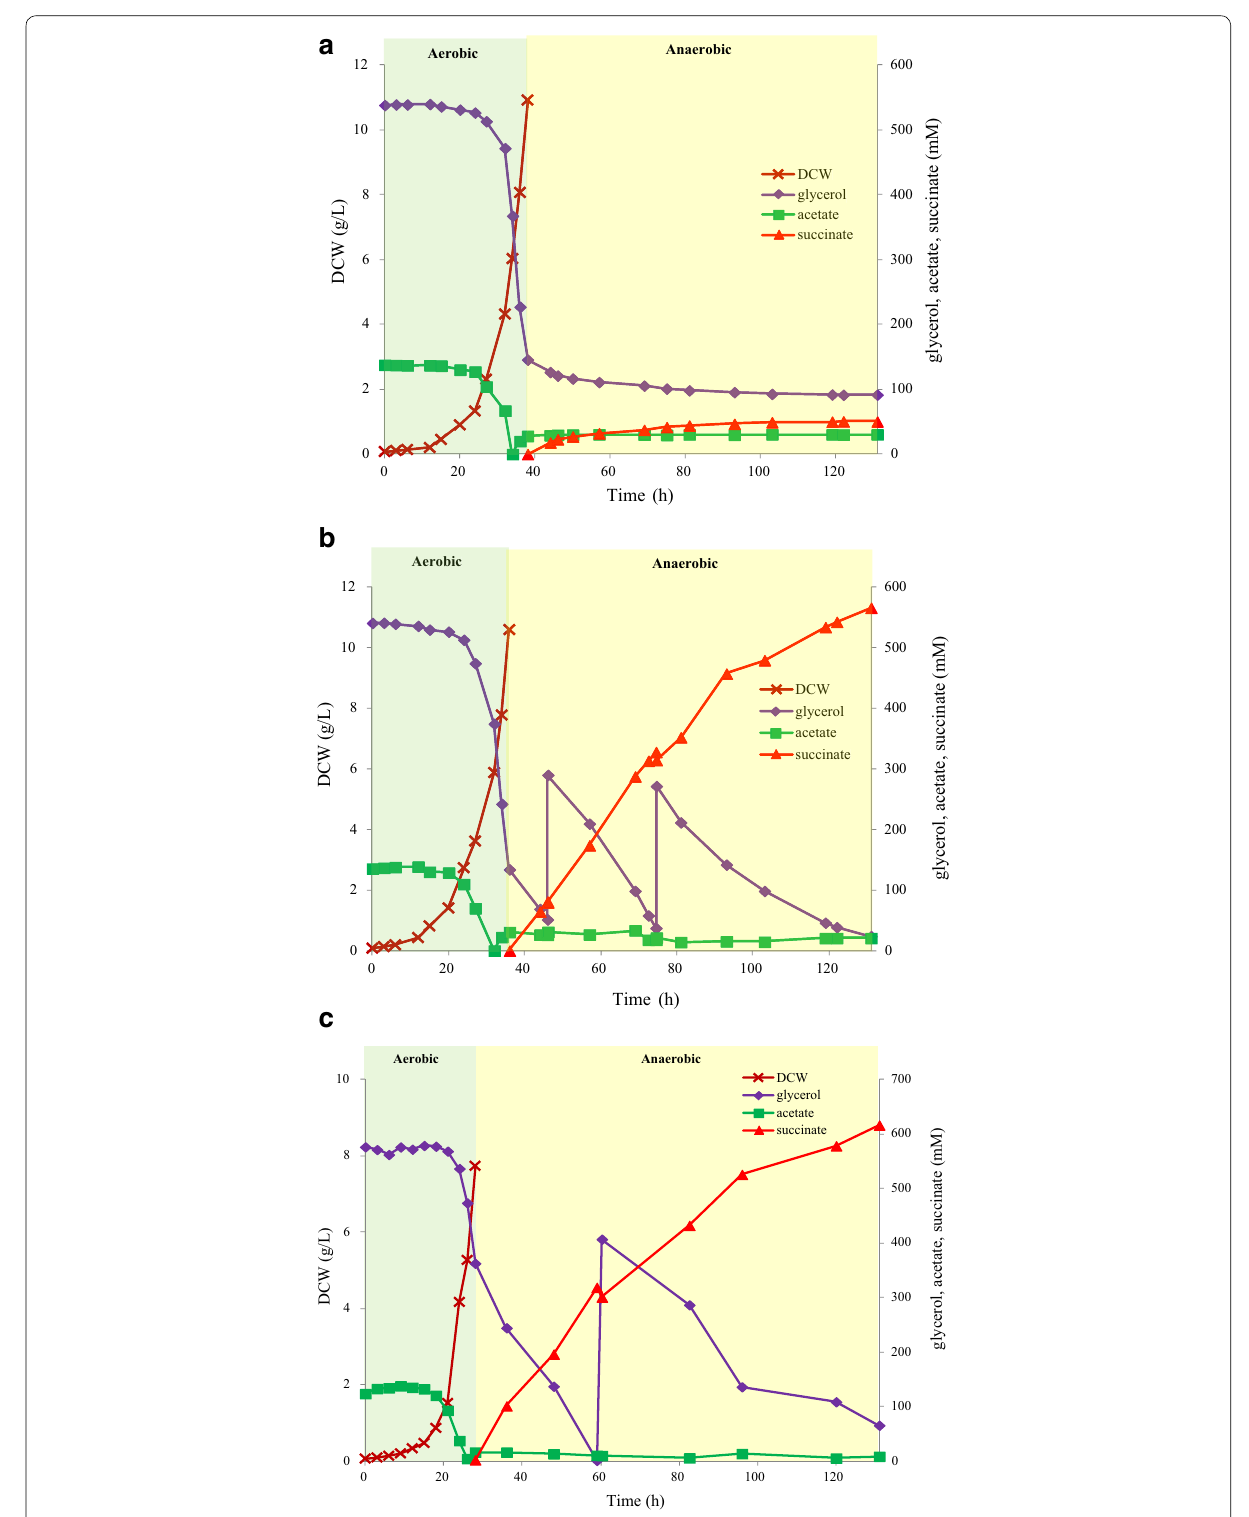
Fig. 3 Two-stage fermentation carried out in a 1.5-L bioreactor by MLB/pTrc99a- pck using different kinds of glycerol as carbon source. a Crude glycerol (B-1); b simply purified crude glycerol (B-2); c pure glycerol (B-3). About 10 g/L of ammonium acetate were added at the beginning of the aerobic stage in these three different fermentations as the co-carbon sources with